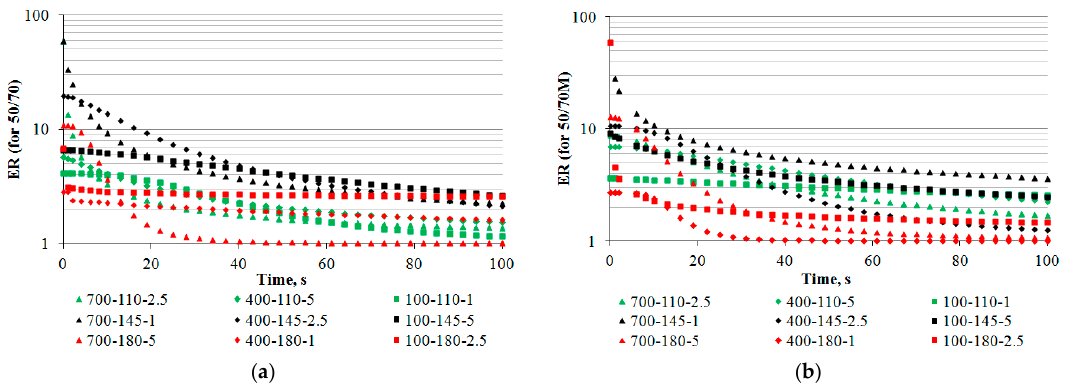
Figure 3. Distribution of bitumen foam according to the logit of the model (5 s resolution): ( a ) bitumen 50/70; and ( b ) bitumen 35/50 M.